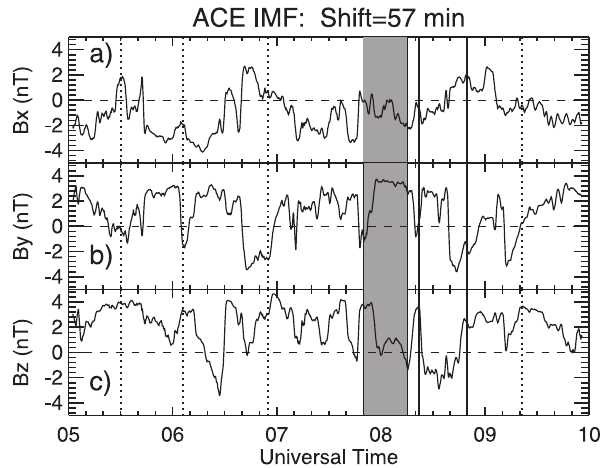
Fig. 3. Interplanetary magnetic field (IMF) x, y and z components in the GSM coordinate system according to the ACE satellite mea- surements on 15 February 2007 between 05:00 and 09:00UT. The data were shifted by 57min. Shaded box correspond to the period during which SA forms were observed by the RES all-sky camera. Vertical solid lines indicate moments of easily recognizable start in the duskward progression of the SA